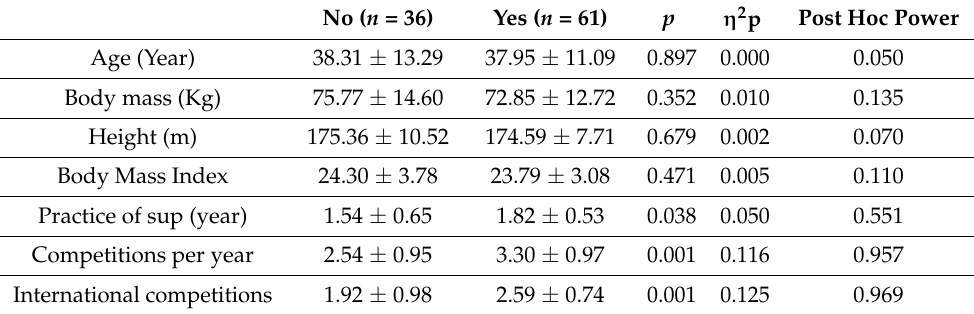
Table 1. Demographic and Body composition data of the participants based on state of injury.